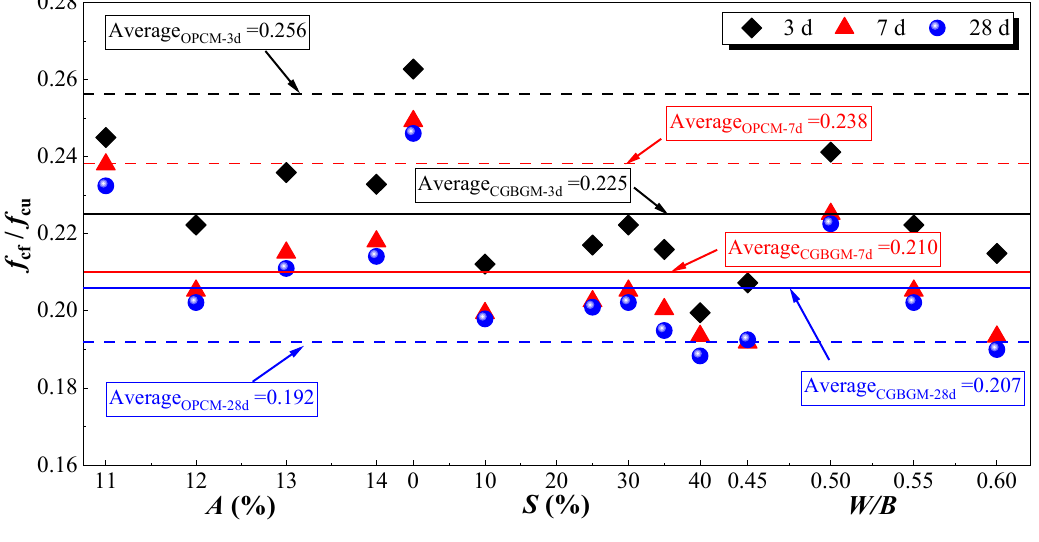
Figure 7. f cf / f cu of the CGBGM.